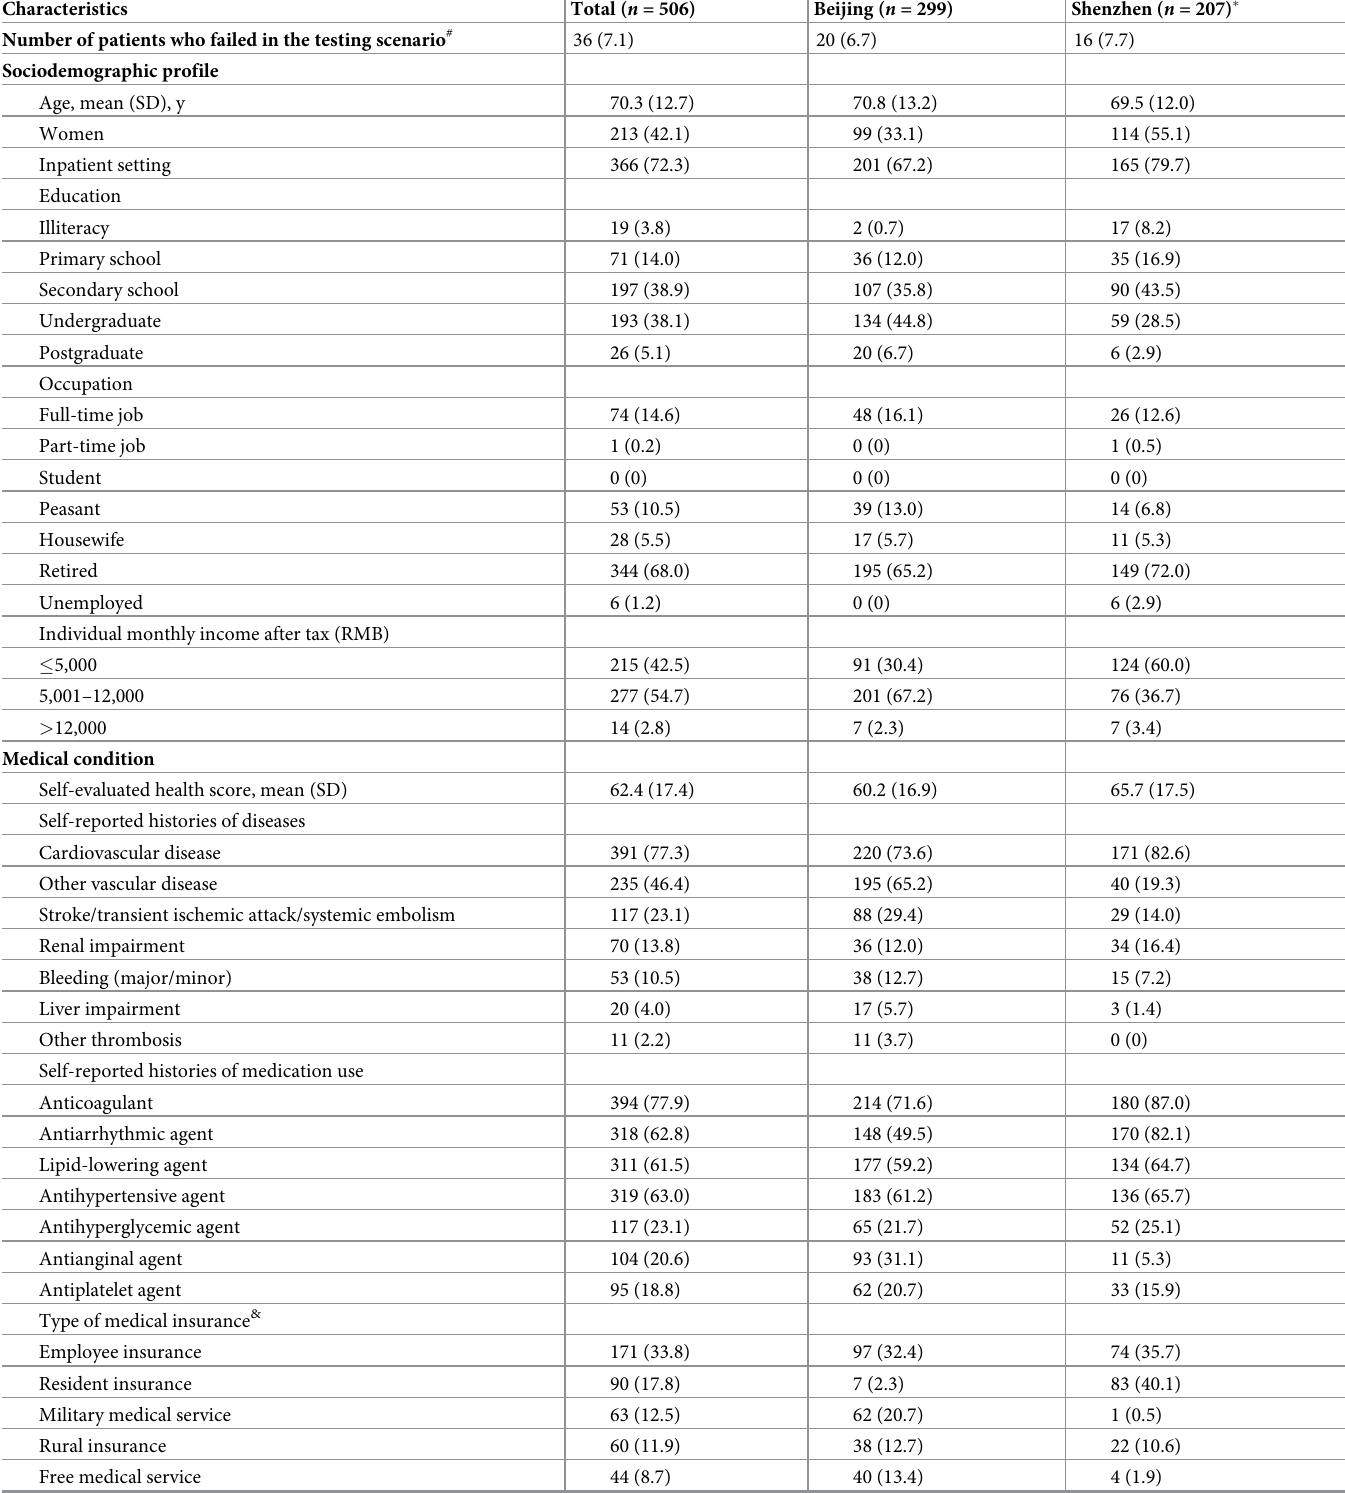
Table 2. Characteristics of recruited